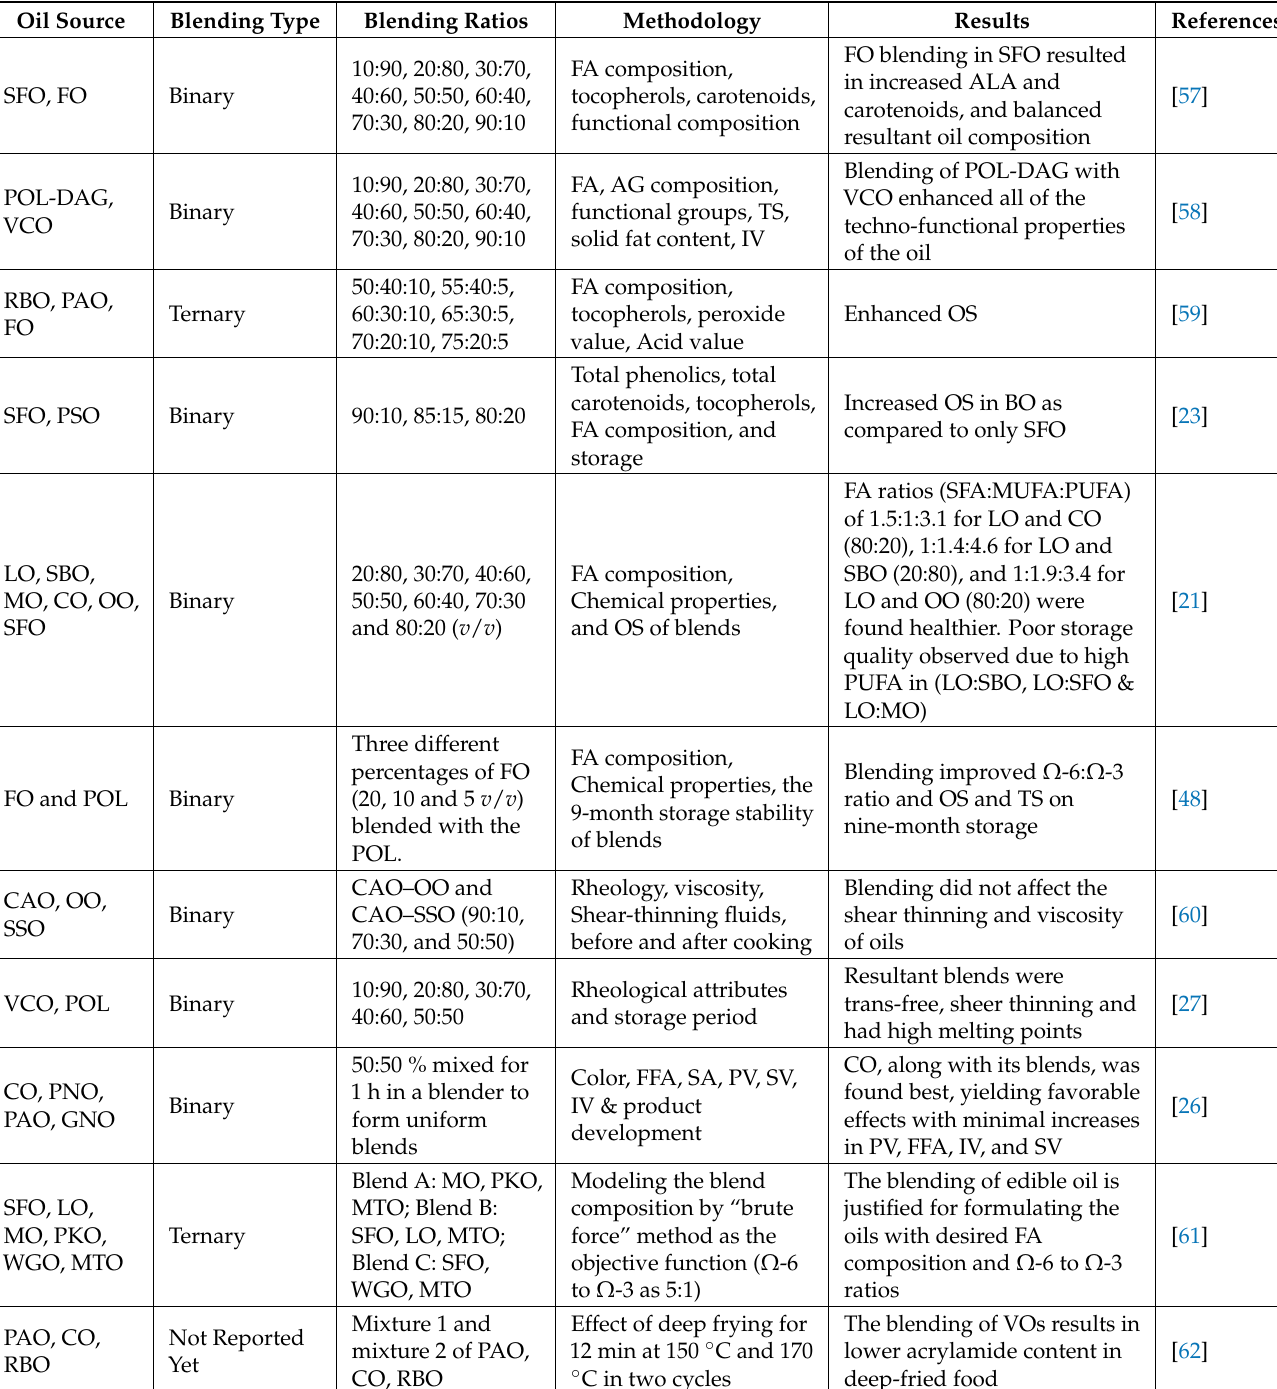
Table 2. Nutritional and physiochemical profile of various blends of selected oils (coconut oil, flaxseed oil, olive oil, sunflower